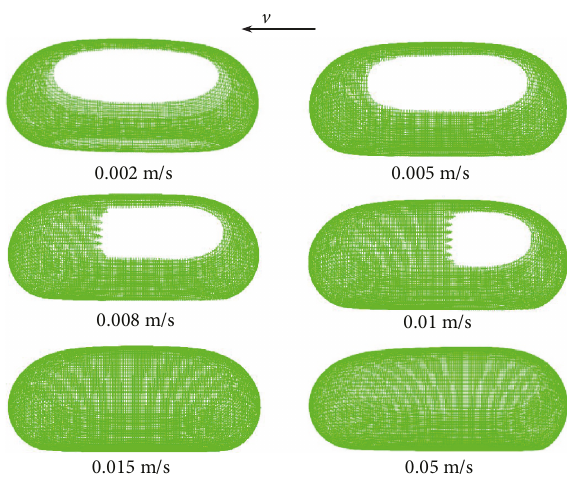
Figure 6: Side views of the oil at di ff erent